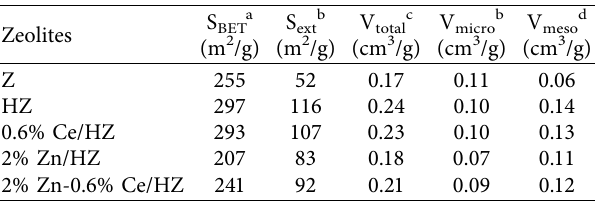
a BETmethod. b t-plot method. c Calculated from the adsorption branch at p/p 0 � 0.99. d V meso � V total -V micro .